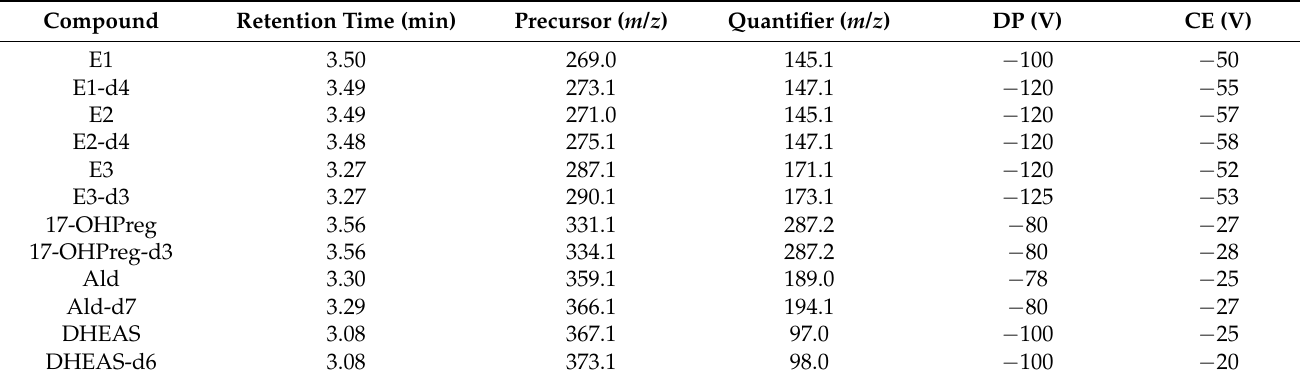
Table 2. Mass spectrometric acquisition